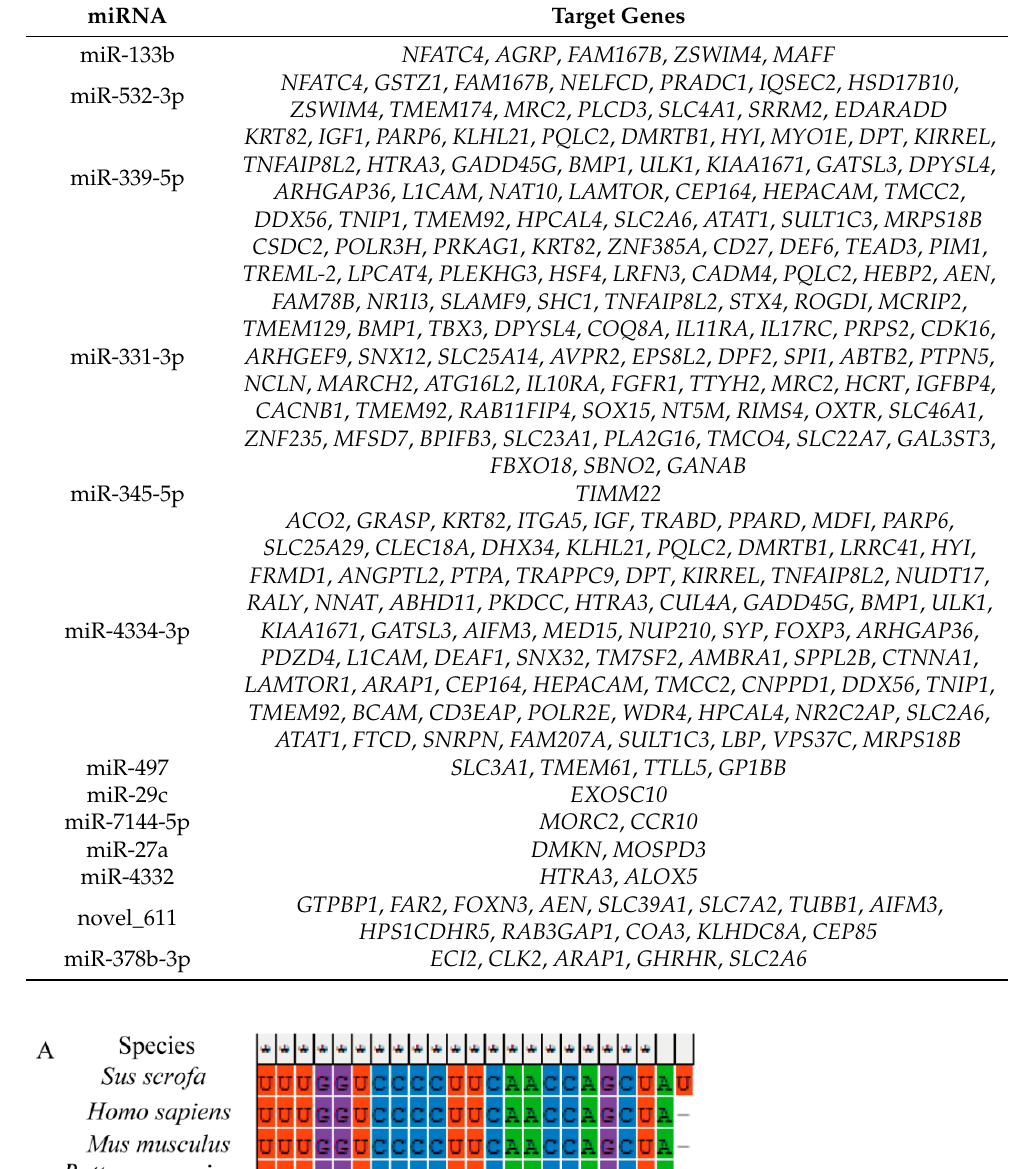
Table 5. The target genes of potential diarrheic resistance-associated miRNAs.